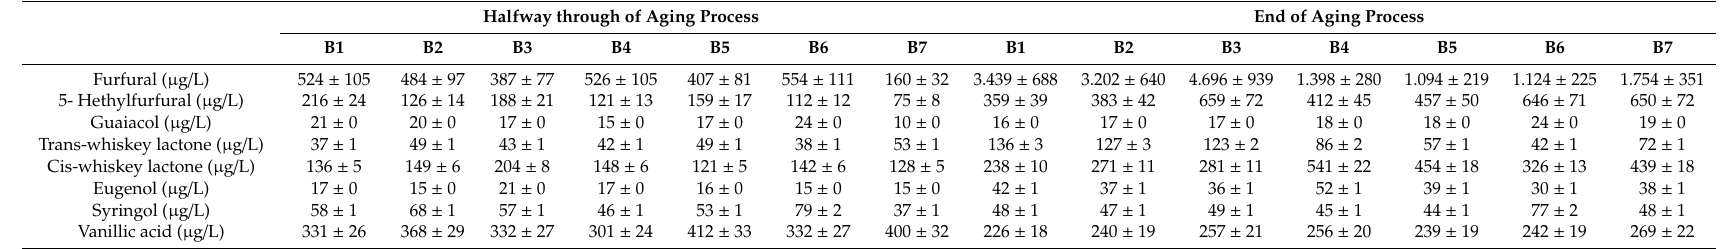
Table 6. Aromatic composition of the wine midway through the aging process and after its completion in the barrels (Result ± SD).